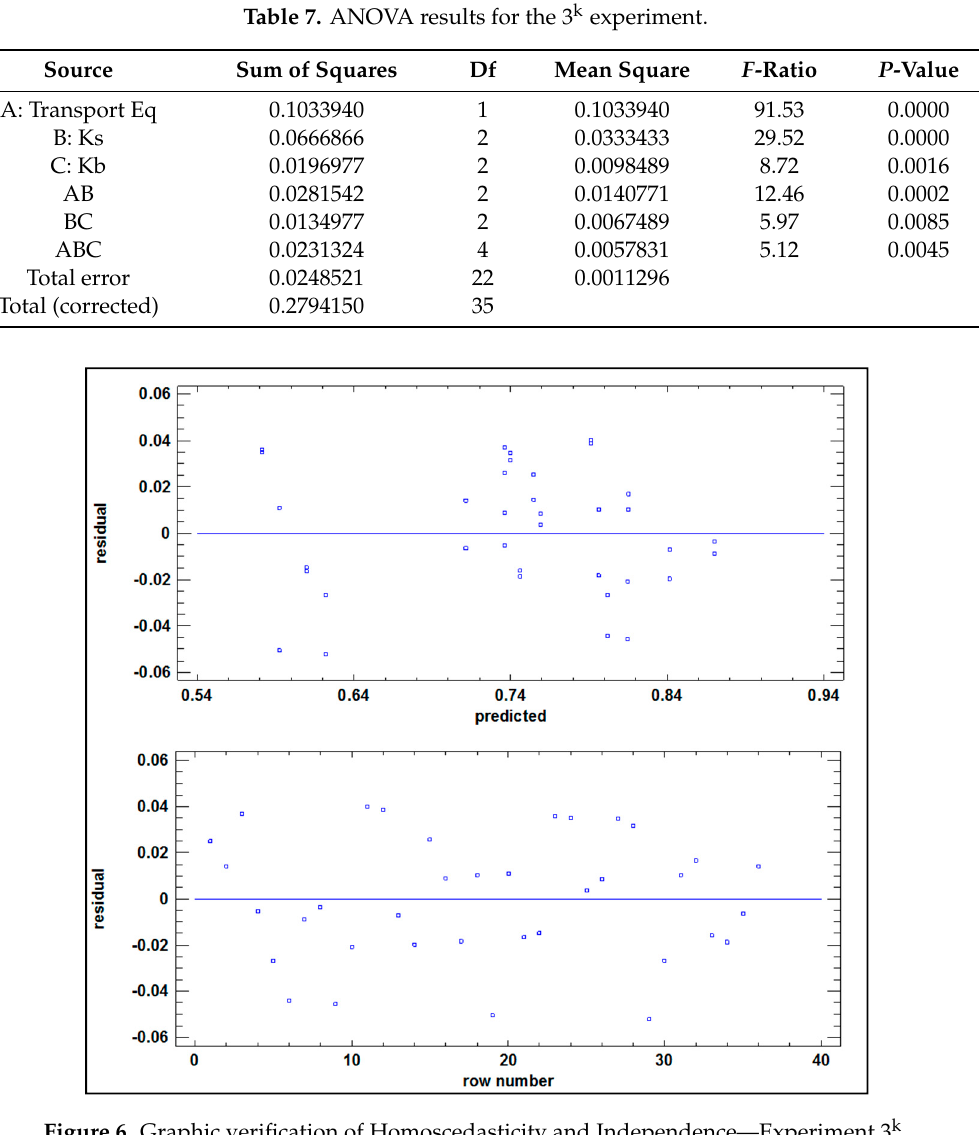
Figure 7. Comparison between Velocity Vectors in two sections of the reach for the optimal case. The morphological evolution was assessed and verified, with no significant instabilities or bathymetric changes found.